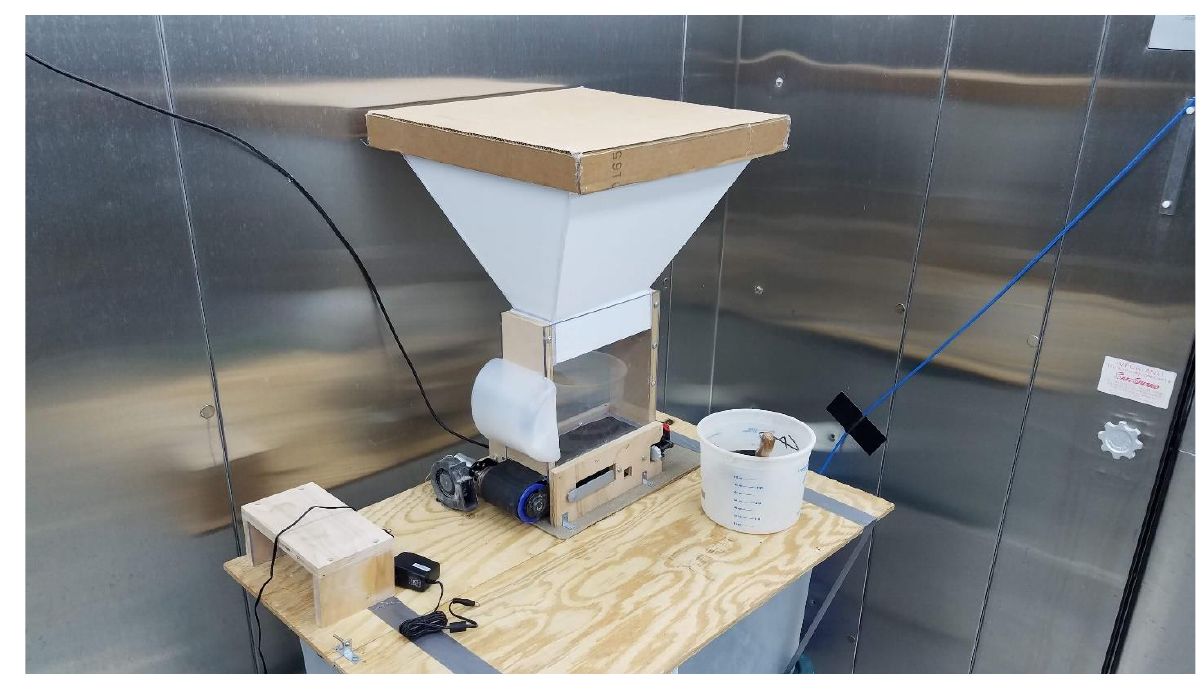
Figure 12. Dust generator placed in controlled environment chamber.